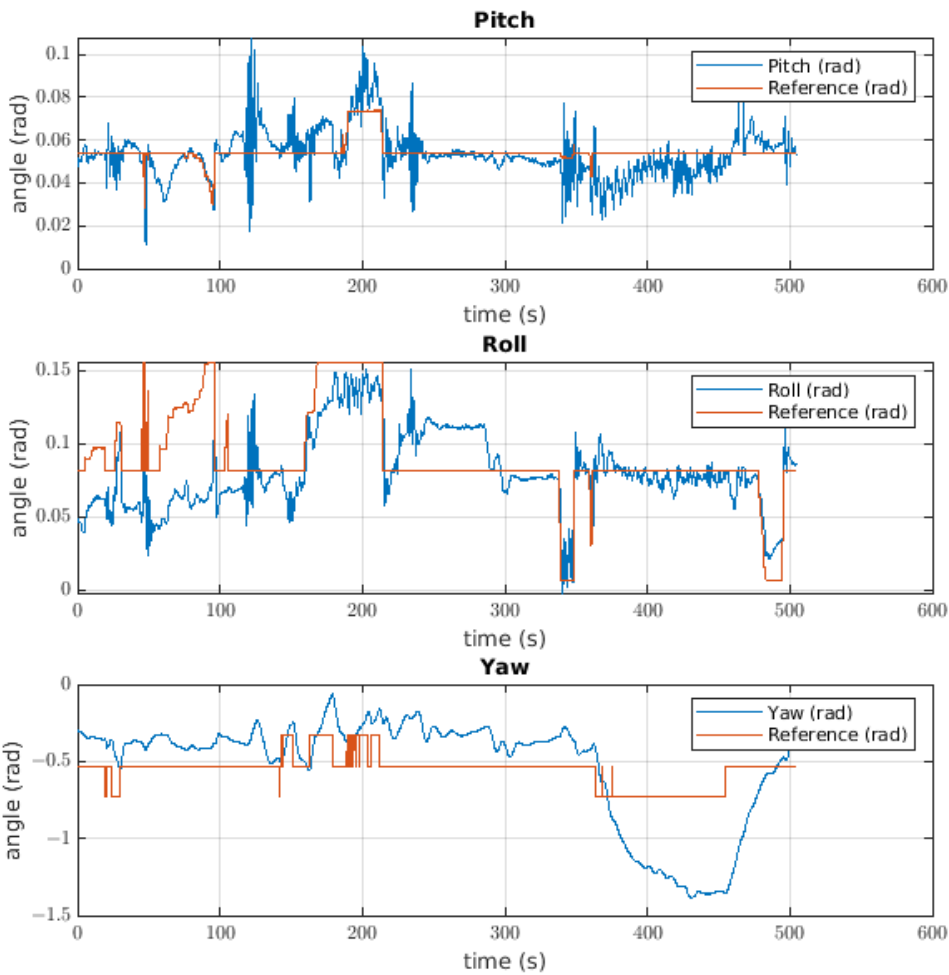
Figure 16. Euler angle behaviour for the attitude controller of the robot taking the